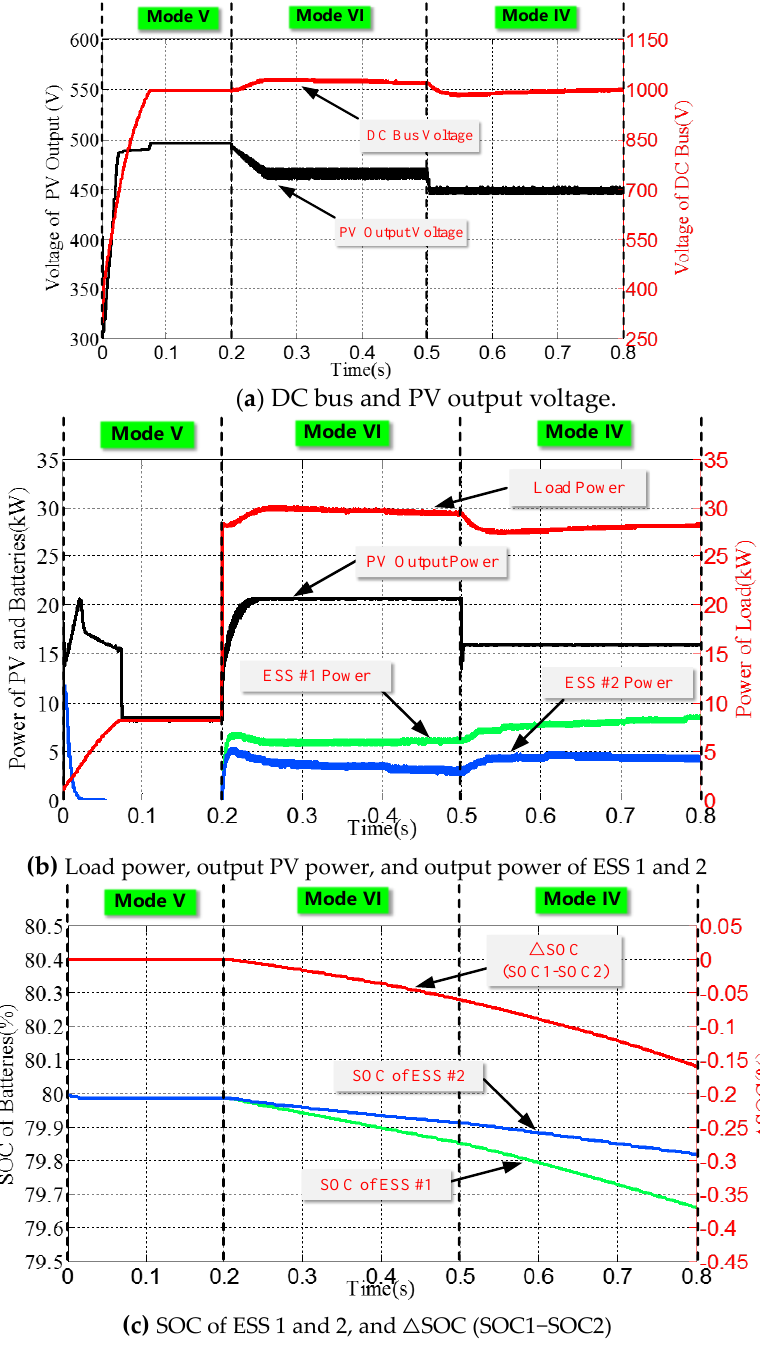
Figure 11. Results of PV-ESS DC microgrid simulation for condition